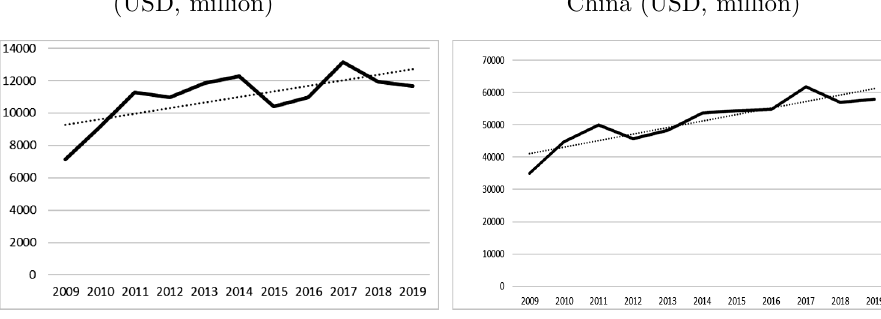
Figure 8. Total imports of V4 from China (USD,